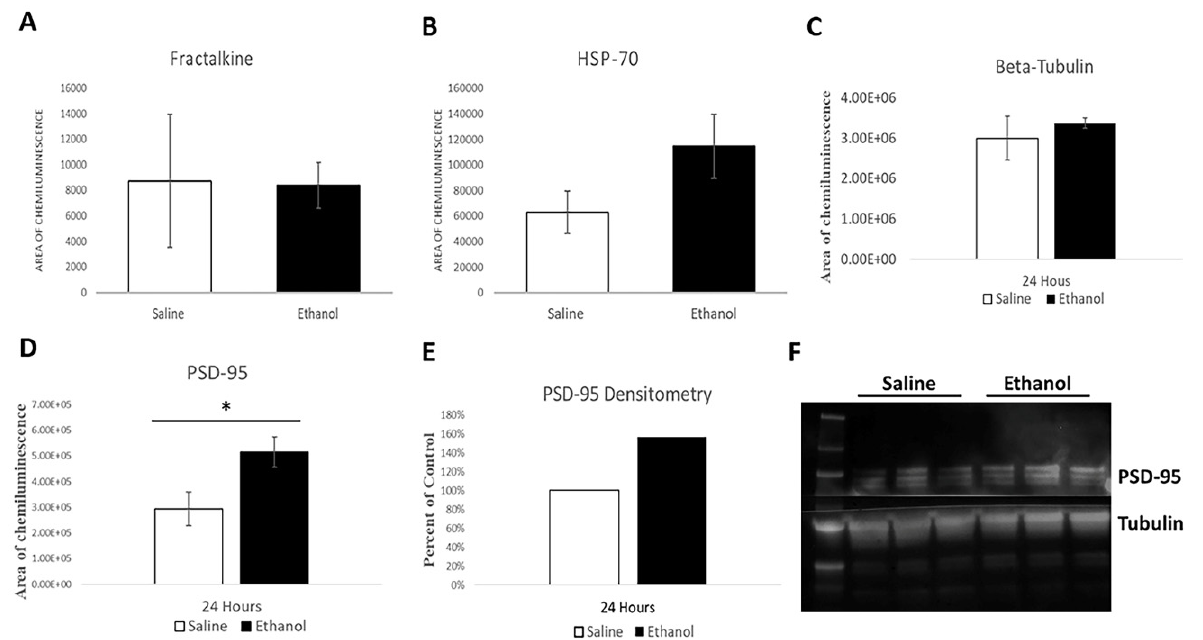
Figure 4. Protein analysis in the striatum of mice 24 h following saline or ethanol administration. ( A ). Fractalkine levels are not affected by ethanol treatment ( p = 0.477). ( B ). Hsp-70 is increased in response to ethanol treatment, but this differ- ence is not significant ( p = 0.084). ( C ). Beta-tubulin levels are not affected by ethanol treatment ( p = 0.281). ( D ). PSD-95 is increased in response to ethanol-treatment ( p = 0.033). ( E ). Western blot analysis of PSD-95 protein in mouse striatum, normalized with beta-tubulin ( n = 6 mice for both ethanol and saline samples). ( F ). Representative Western blot of PSD-95 and tubulin proteins from mouse striatal tissue. Each lane represents a striatal sample from a different mouse. For all panels, error bars represent SEM values. *: p < 0.05.